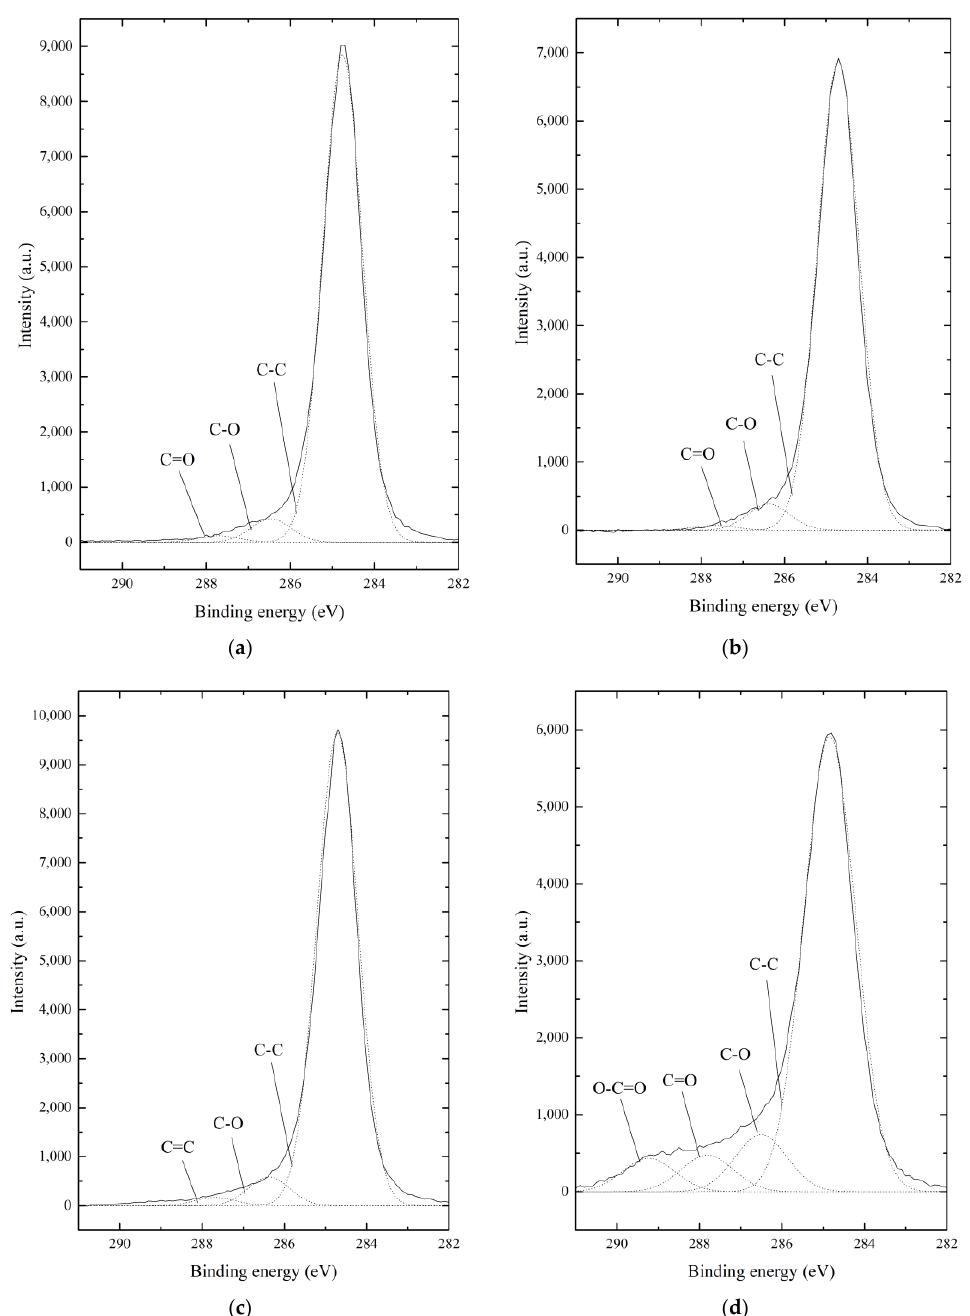
Figure 11. C1s spectra of the PP surface after being treated by ( a ) none, ( b ) APPJ only, ( c ) sanding only, and ( d ) both sanding and APPJ.